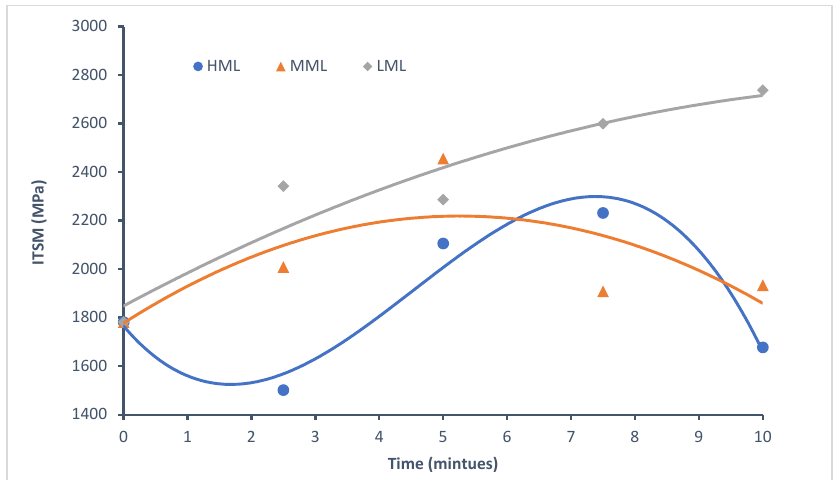
Figure 4. Effects of varying MW energy and time on the ITSM of 5.5% PSA-containing CBEMs. HML: High microwave level; MML: Medium microwave level; LML: Low microwave level.